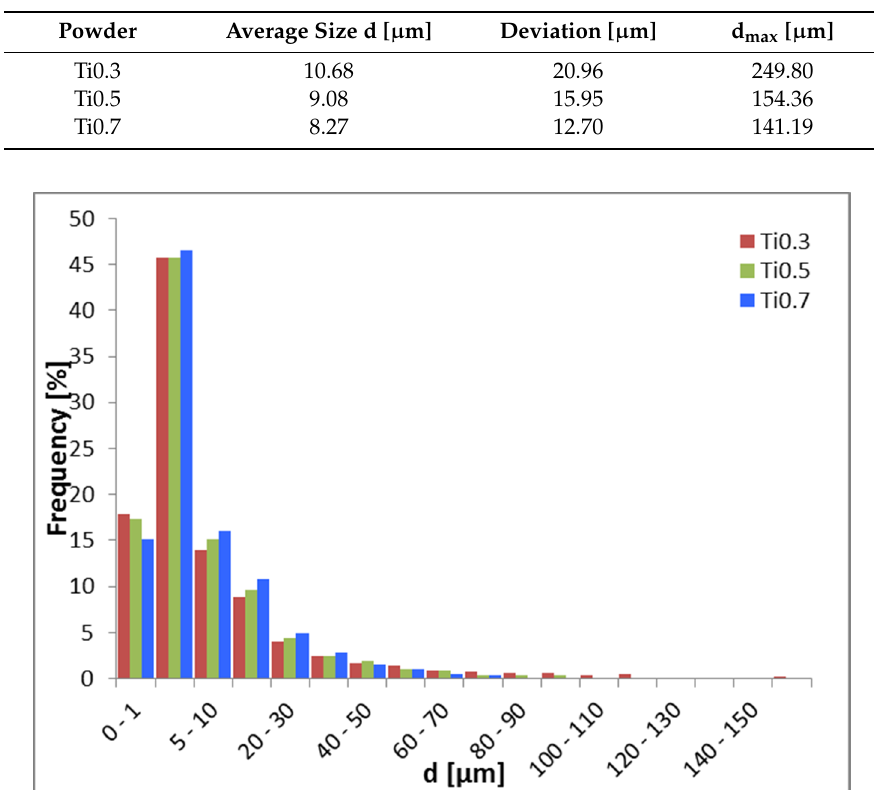
Figure 1. Histogram of powder particles distribution of Tix alloys. The largest fraction of particles have a size between 1 and 5 µm. Particles with size larger than 100 µm are significantly frequent only in the case of Ti0.3 powder.